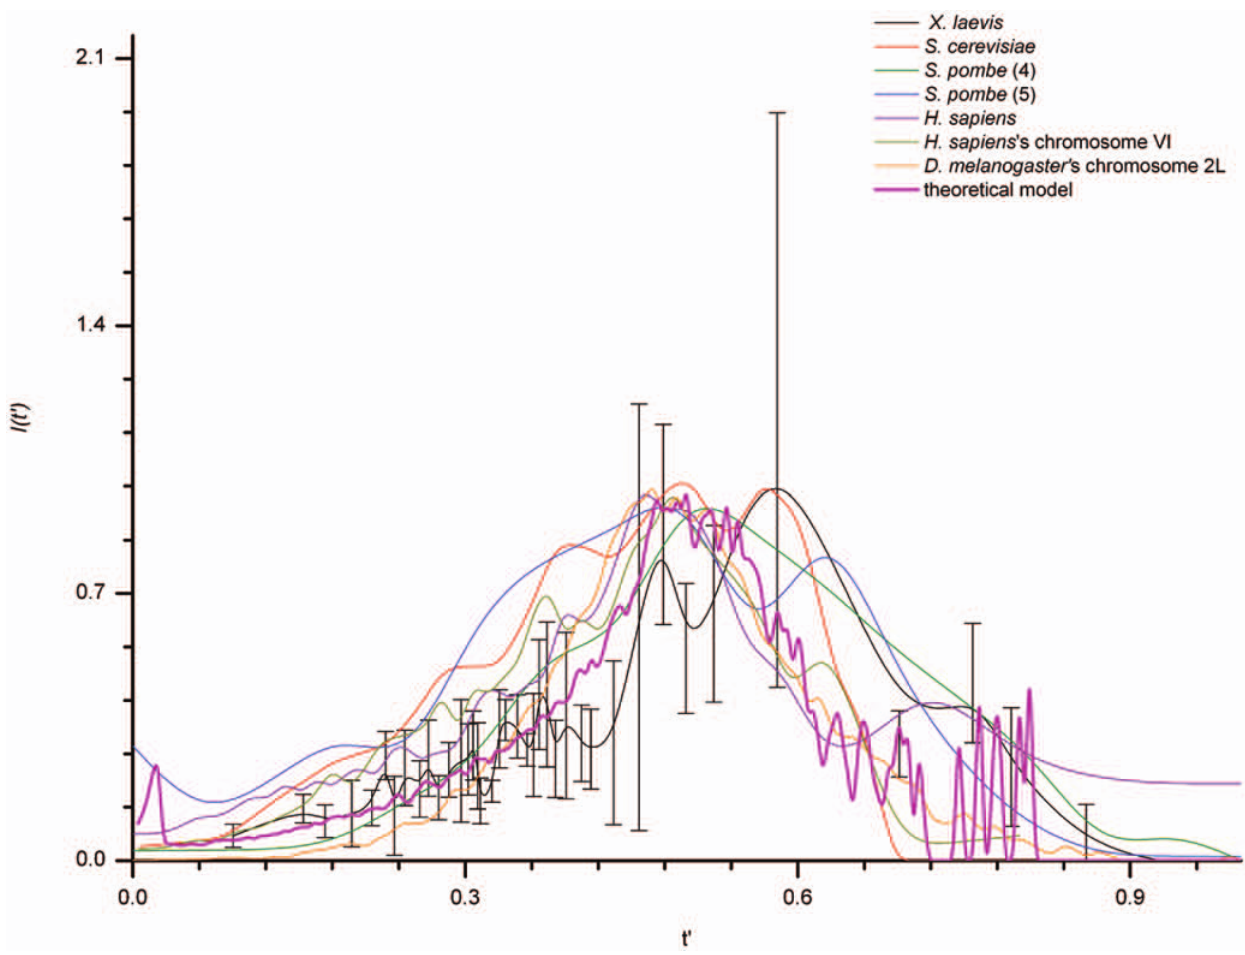
Figure 3. Collapse of all I(t’) . All curves were shifted horizontally so that their starting points coincide with zero. The similarity distance (d sim ) between the I(t’) of other eukaryotes and the I(t’) of X. laevis (Black) was measured using the Continuous Dynamic Time Warping method (see Material and Methods). By using the X. laevis data dispersion (gray error bars) we set the condition that if the measured distance between two curves is smaller than 0.94, the two curves are similar. In all cases we found d sim , 0.94, therefore all I(t’) , including the one generated by the numerical model, could be considered as similar. However, its possible to define a sequence of decreasing similarity between considered I(t’) as: H. sapiens ‘s chromosome 6 (d sim =0.27, Dark yellow) . D. melanogaster (d sim =0.38, Orange) . numerical model (d sim =0.41, Magenta) . S. pombe from Heichinger et al (d sim =0.43, Olive) . H. sapiens (d sim =0.44, Purple) . S. pombe from Eshaghi et al (d sim =0.55, Blue) . S. cerevisiae (d sim =0.85,